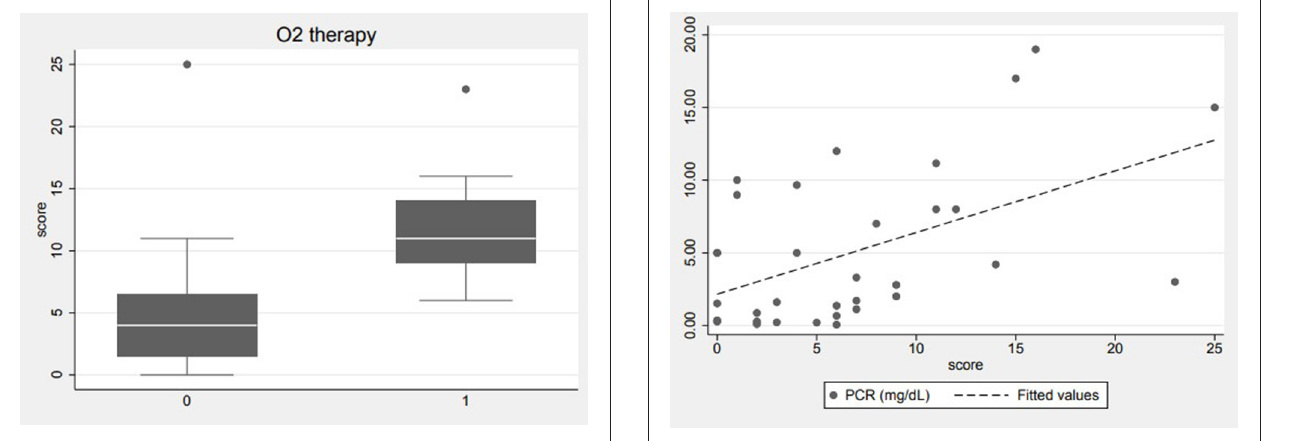
FIGURE 3 | Correlation between C-reactive-protein levels and LUS